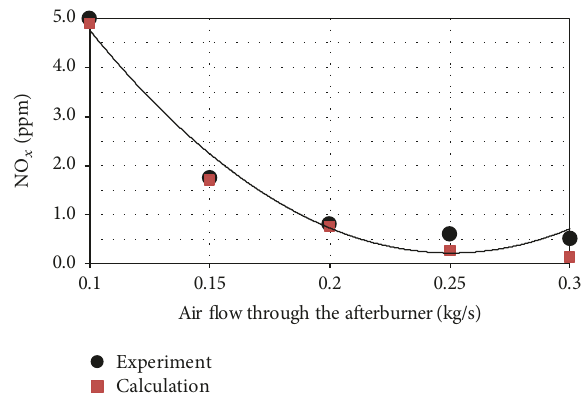
Figure 3: Experimental and calculated dependence of nitrogen oxides emission on air consumption via the